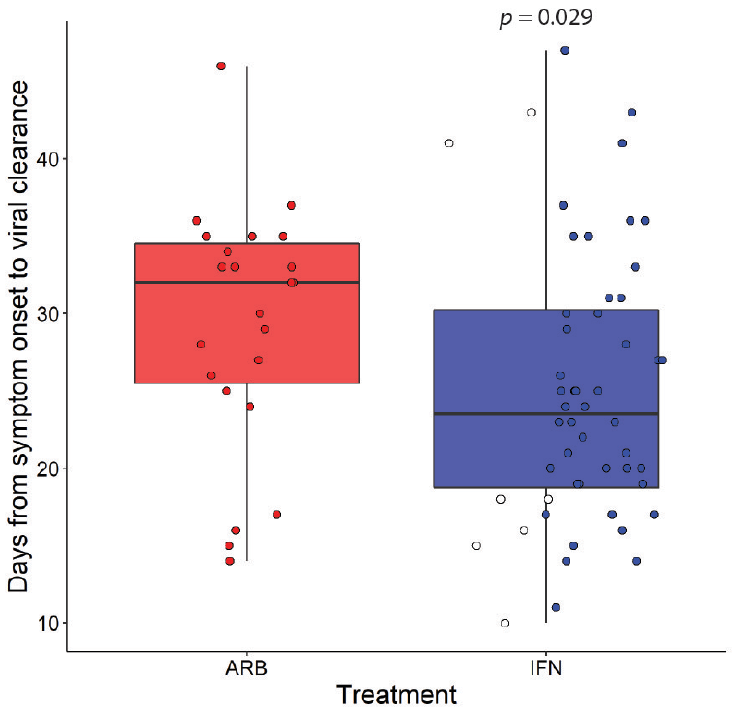
Figure 1. Interferon (IFN)- α 2b treatment accelerates viral clearance. Coronavirus disease 2019 (COVID-19) cases were treated with either arbidol (ARB) alone (ARB, n = 24) or IFN- α 2b with or without ARB (IFN, n = 53). Data points for cases treated with IFN alone are marked as open circles. Time to viral clearance from symptom onset is indicated; p value was calculated using Wilcoxon signed-rank test. These plots are re-derived from published data employing different population parameters